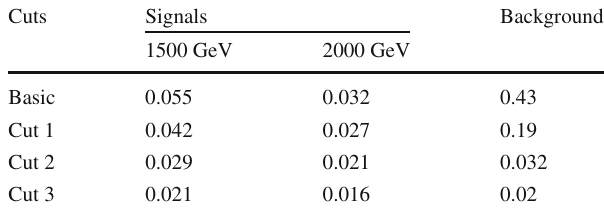
Table 2 Cut flow of the cross sections (in fb) for the signals and SM background at the 3 TeV CLIC with g ∗ = 0 . 3 for the (cid:6) 2 b 2 j + / E T final state Cuts Signals